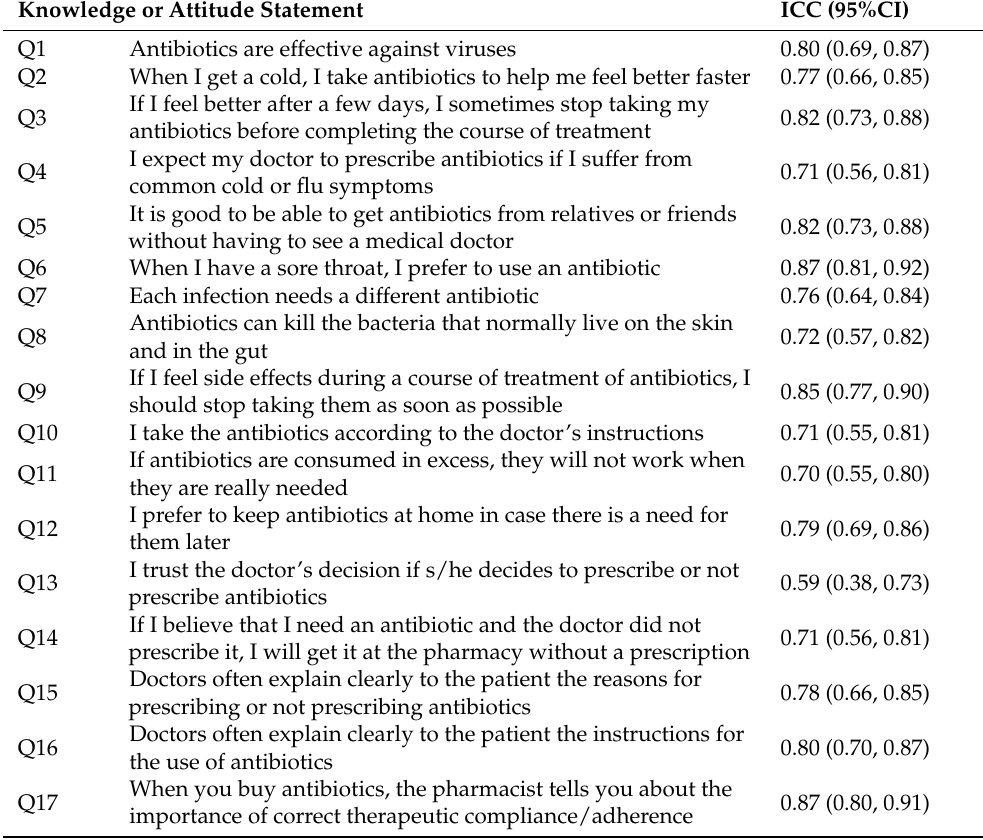
Table 1. Test–retest reliability assessment of knowledge and attitudes statements of the KAP ques- tionnaire on antibiotic